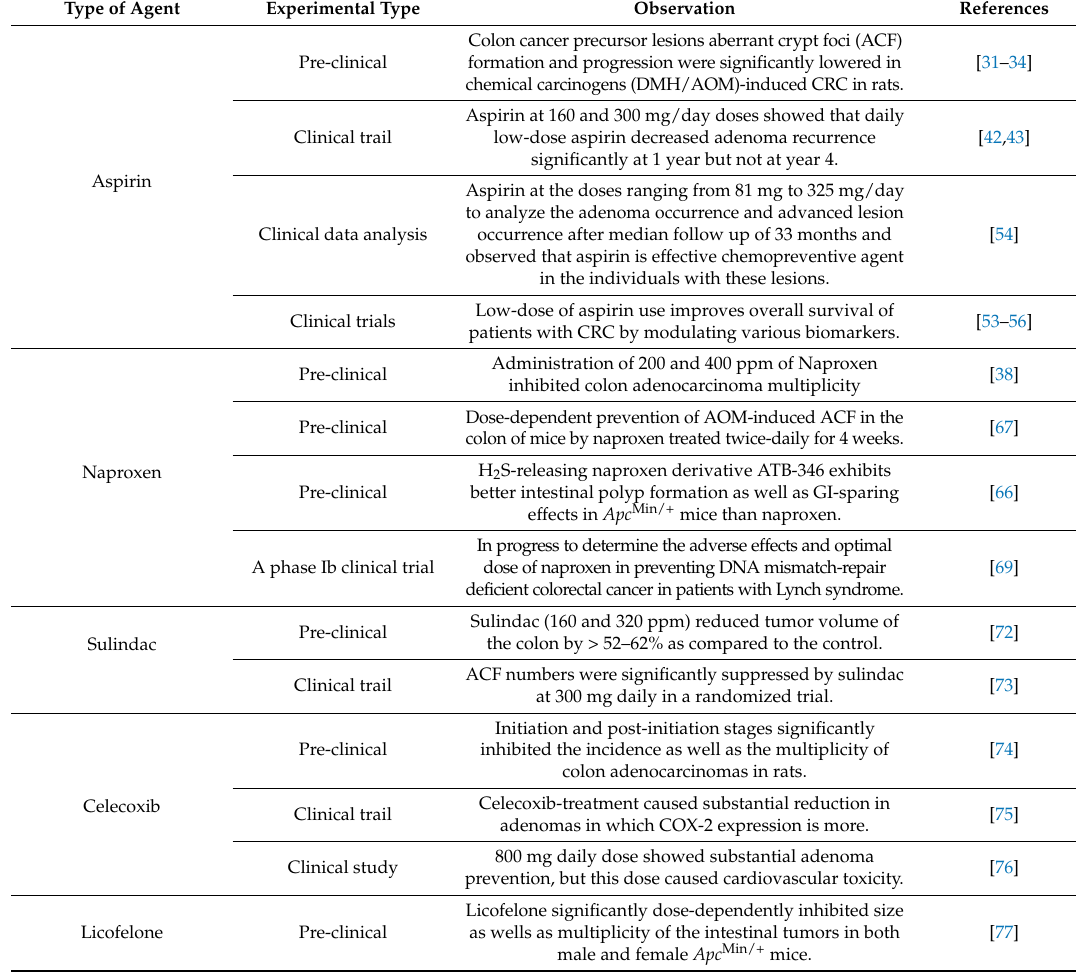
Table 2. Chemopreventive potentials of selected anti-inflammatory agents against colon